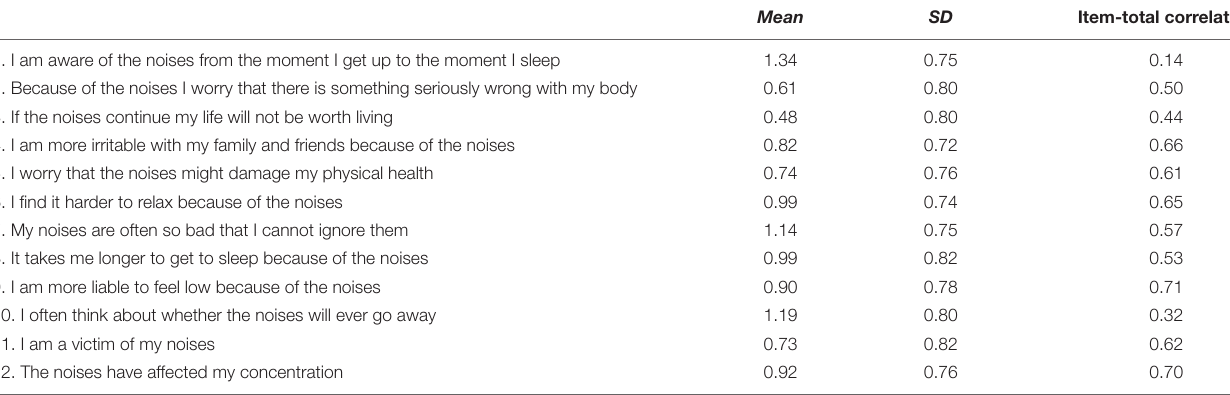
TABLE 2 | Mean, standard deviations, and variance of the TQ 12-I.